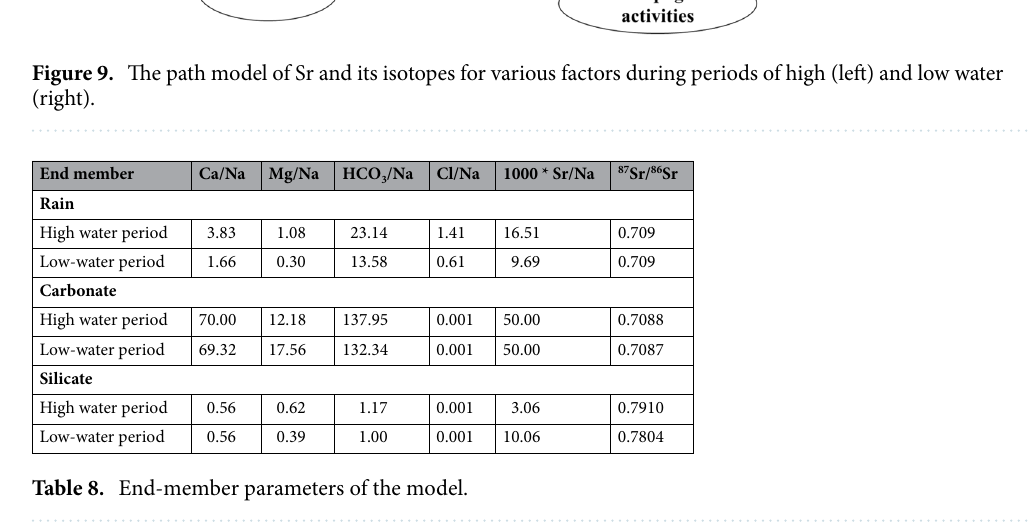
Table 8 indicates that the difference between the basic elemental ratio and Sr isotope ratio of the carbonate end-member during the high- and low-water periods was small while there was a large difference in the Sr isotope